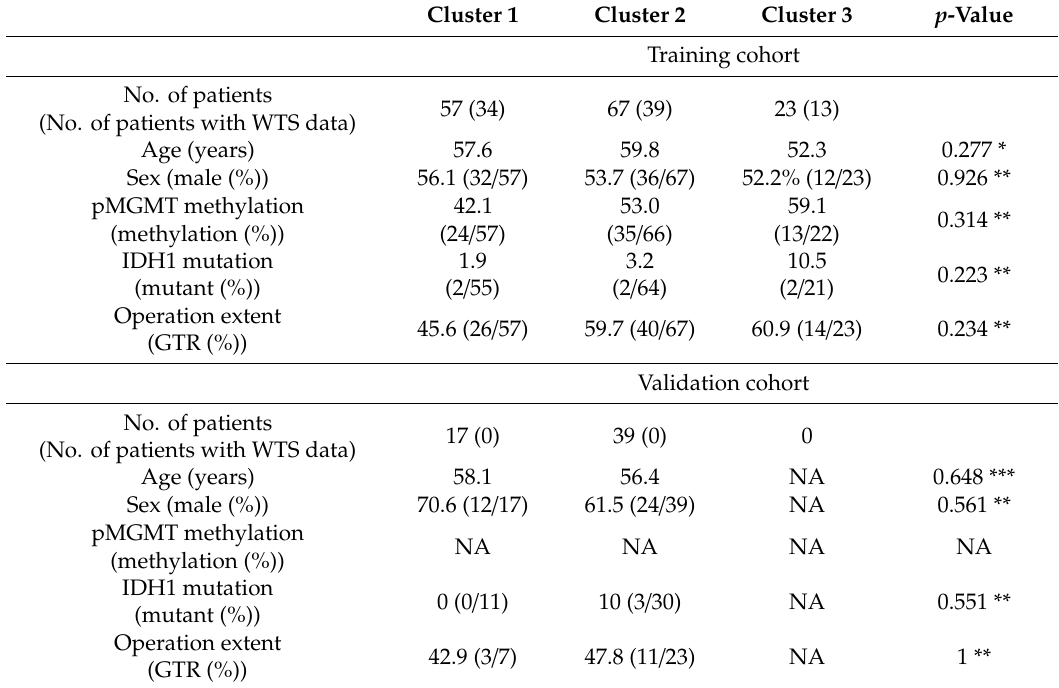
Table 2. Clinical and molecular characteristics of radiomics-defined